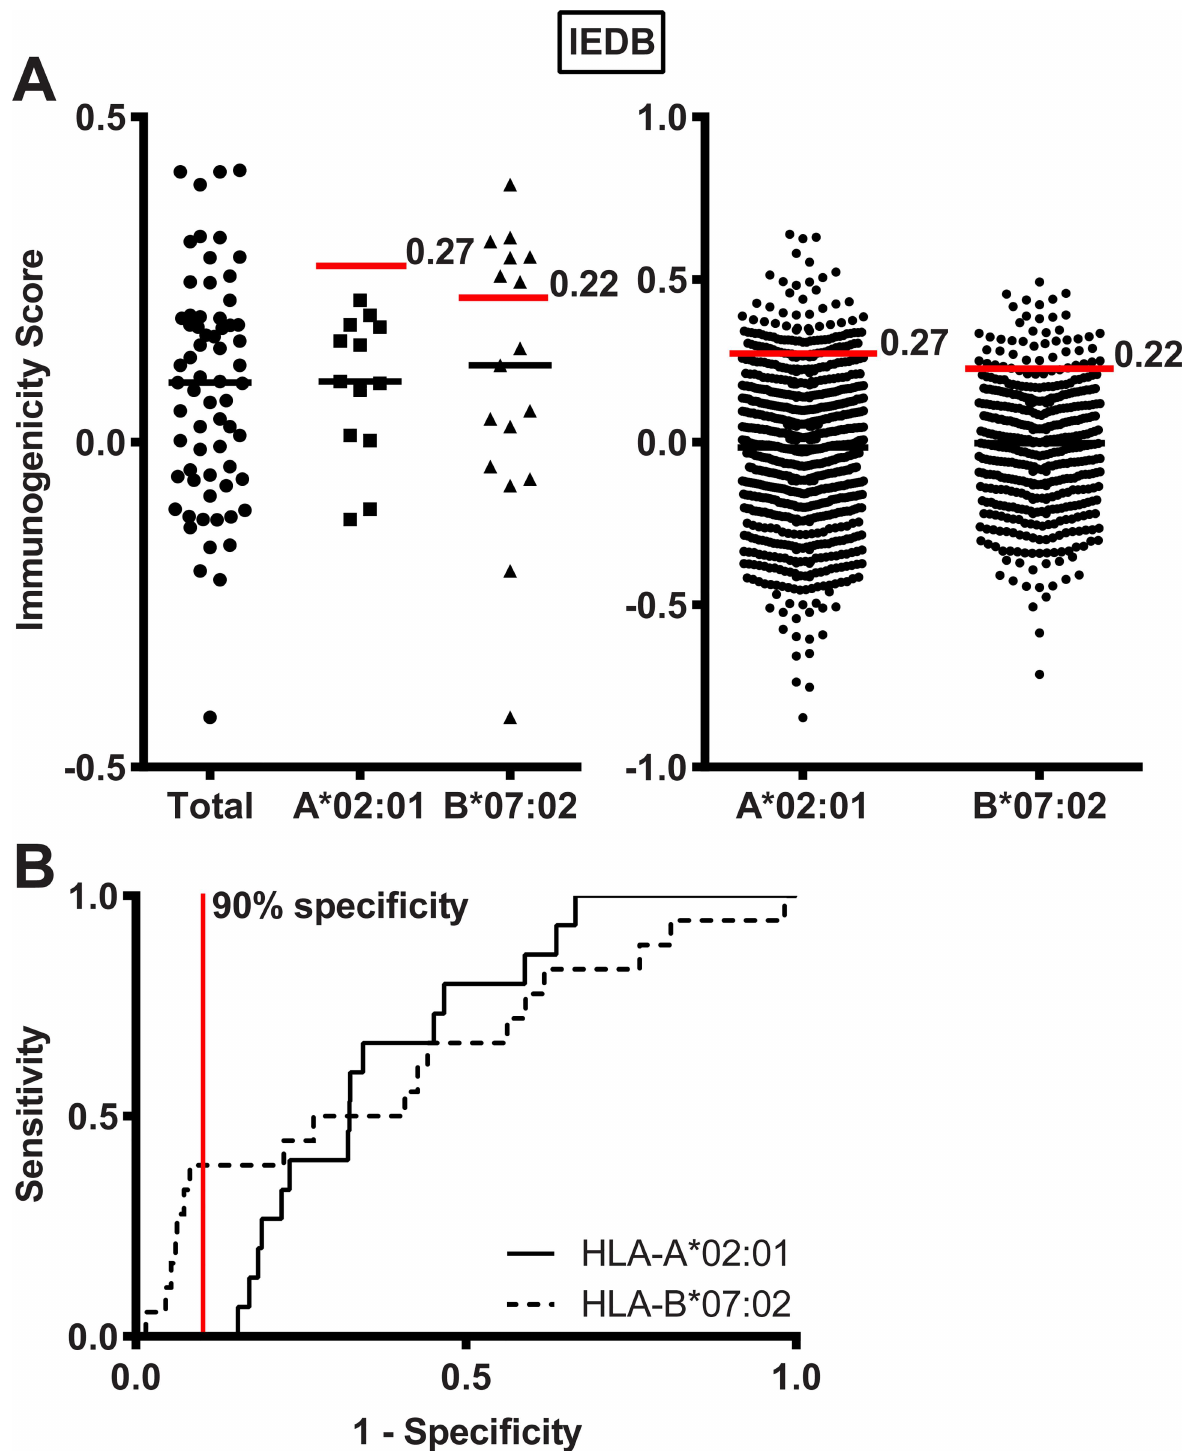
Fig 3. Predicted in vivo immunogenicity. (A) Invivo immunogenicity as predictedby the MHC I immunogenicity tool of the IEDB for the total group of MiHA (n = 65) and for MiHA with predictedbindingto HLA-A * 02:01(n = 13) or HLA-B * 07:02(n = 17) by NetMHCpan 2.8. Indicated are immunogenicity scoresfor MiHA (left)and reference peptides(right).Designatedare medianimmunogenicity scores (black horizontallines) and thresholds of 0.27 and 0.22 to defineimmunogenic peptidesfor MiHA bindingto HLA-A * 02:01 or HLA-B * 07:02, respectively (red lines).The data show a significantdifference in proportionof immunogenic peptidesbetween